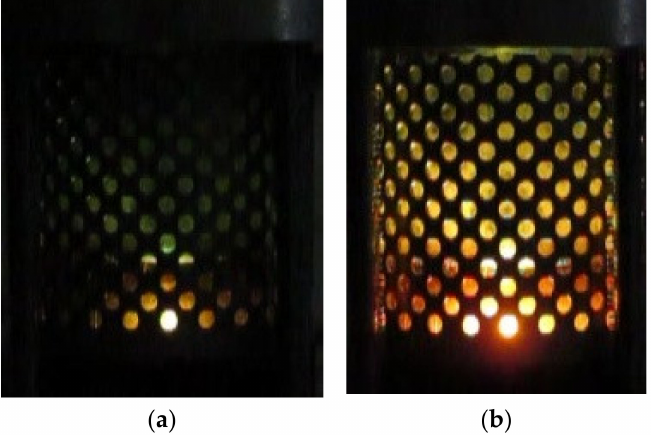
Figure 4. Two successive frames of microwave discharge in engine oil in installation with coaxial input of microwave energy described in [41,43–45] (shooting speed is 240 frames per second, time interval between figures ( a ) and ( b ) is of 4